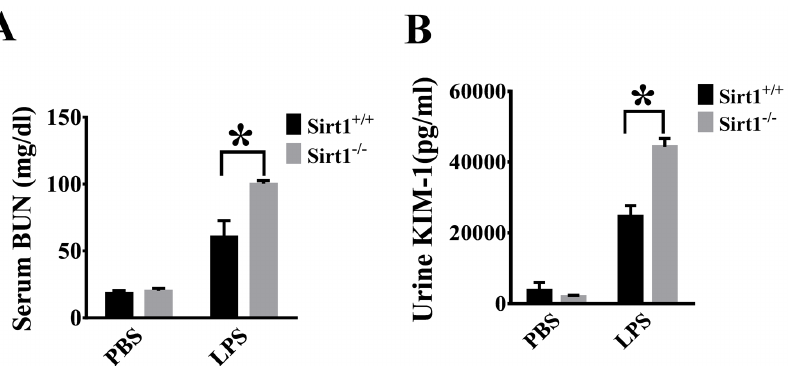
Figure 1. Aggravated renal dysfunction in Sirt1 knockout mouse after LPS challenge. Sirt1 2 / 2 mice and Sirt1 + / + littermates were divided into four groups (Sirt1 + / + /PBS, Sirt1 2 / 2 /PBS, Sirt1 + / + /LPS, Sirt1 2 / 2 /LPS). Serum BUN (A) and KIM-1(B) Levels were measured 24 h after LPS challenge